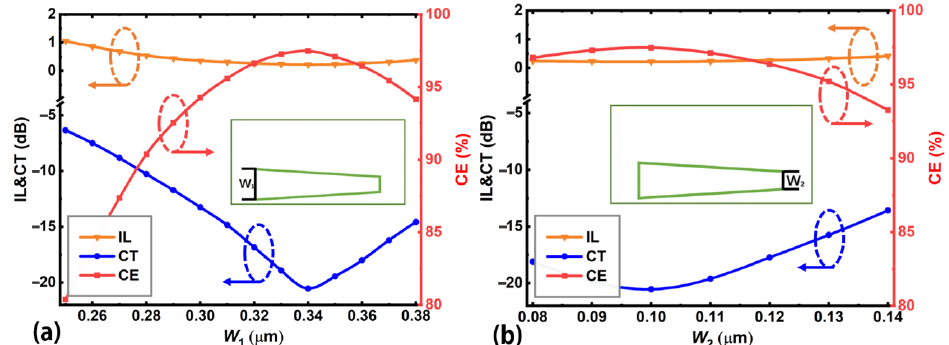
Figure 4. Device performance (mode CE, CT, and IL) as functions of the ( a ) input end width W 1 and ( b ) output end width W 2 of the embedded Sb 2 Se 3 layer for the proposed mode converter. Insets show the definition of the device parameters being calculated.